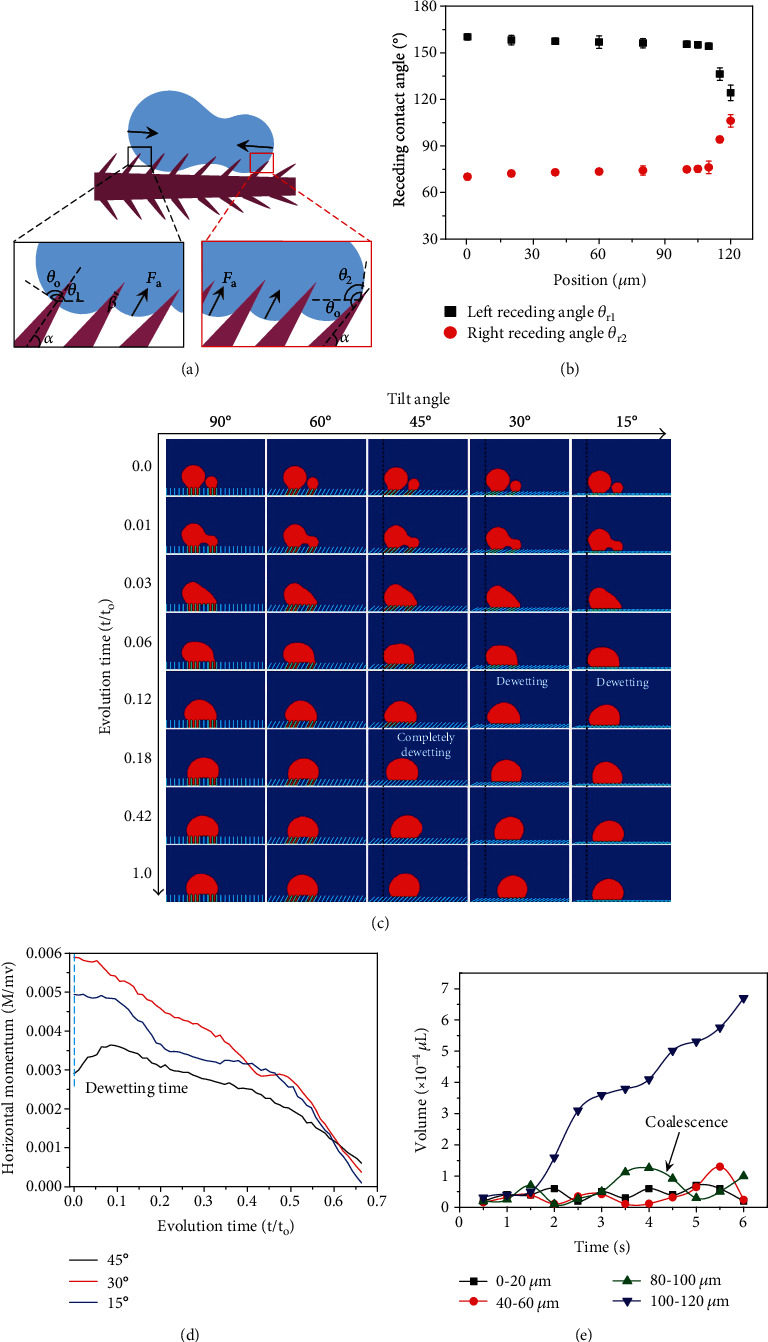
Droplet transport mechanism and characterization. (a) The sketch of coalescence process of two condensed droplets on the nanoratchets. The according receding contact angles under such unstable state can be determined by the geometric analysis in the figures with black (leftmost edge) and red (rightmost edge) borders. The unbalanced geometric induces the unidirectional coalescence of droplets. (b) The variation of calculated left and right receding angles as a function of location. Along the whole seta, the left receding contact angle is always larger than the right receding contact angle, leading to dFd1 > dFd2. The error bars represent the standard deviation of the measurements. (c) Lattice Boltzmann (LB) simulation of the coalescence process of two Wenzel droplets of different size on surfaces of equivalent length and various tilt angles ranging from 90° to 15°. There is a preferential dewetting on ratchet arrays with tilt angles of 90° and 60°, respectively. For ratchet arrays with smaller tilt angles, the merging droplet could dewet from the cavities of ratchets and then move along the tilt ratchet structure, which is in contrast to the uniform surface on which the small droplet will move toward the large droplet during the coalescence. (d) Time-dependent variation of the horizontal momentum of the dewetting droplets on surfaces with a tilt angle of 15°, 30°, and 45°, respectively. The time 0 is counted when the droplet completely dewets from the ratchets (in the vertical direction). M means the momentum, m is the mass, and v represent the velocity in lattice unit. t and to are the evolution time and total evolution time, respectively. (e) The variation of the volume of condensate droplets as a function of time and spatial location, with 0 μm and 120 μm being the bottom and apex of seta, respectively.